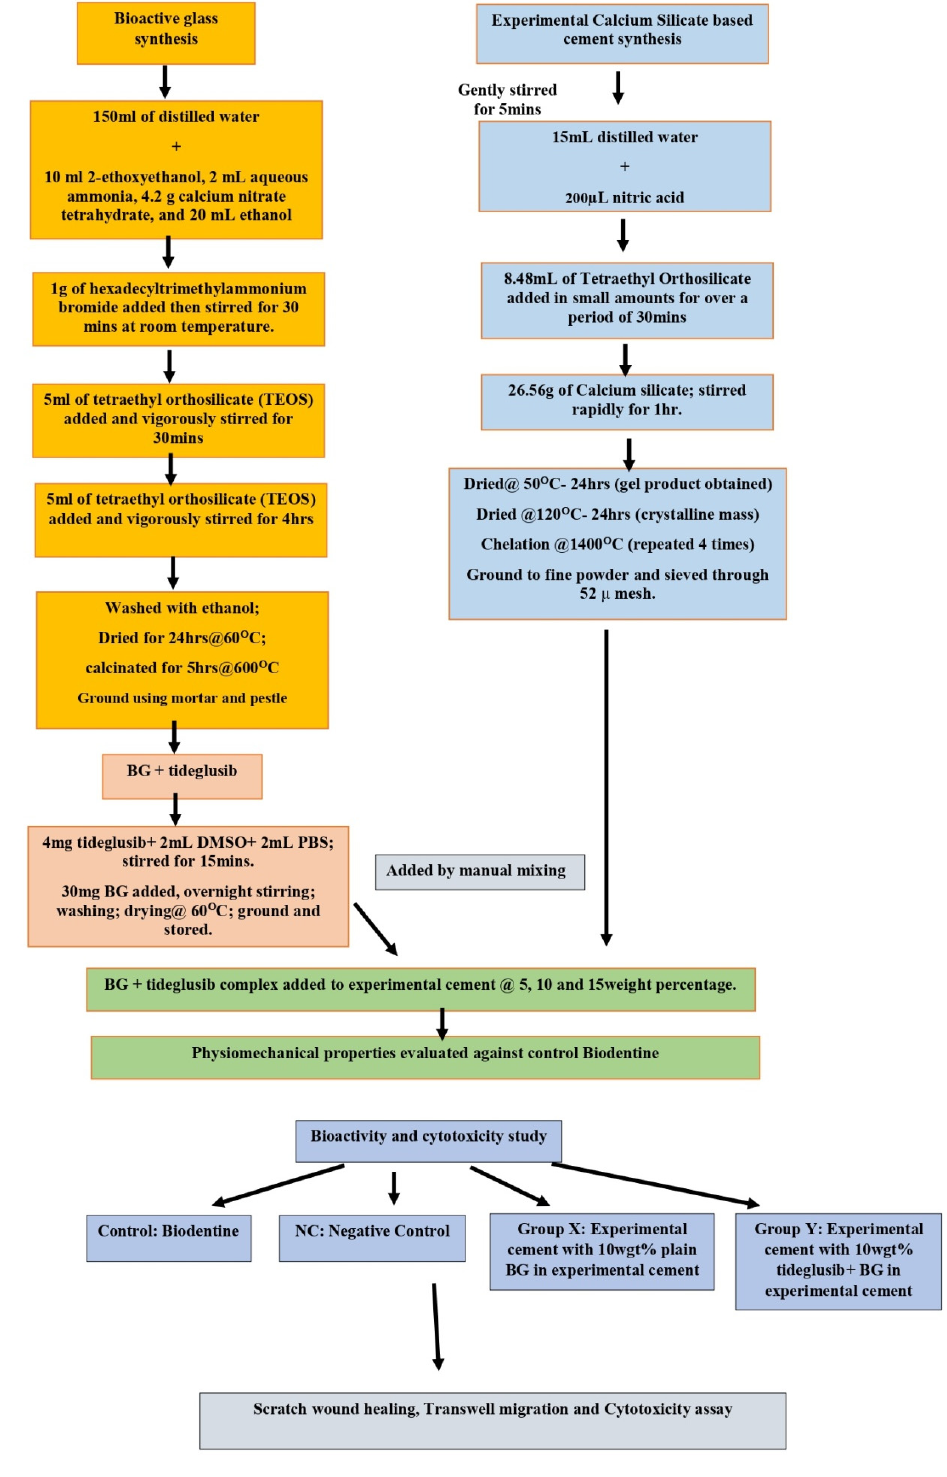
Figure 1. Schematic workflow of this study.